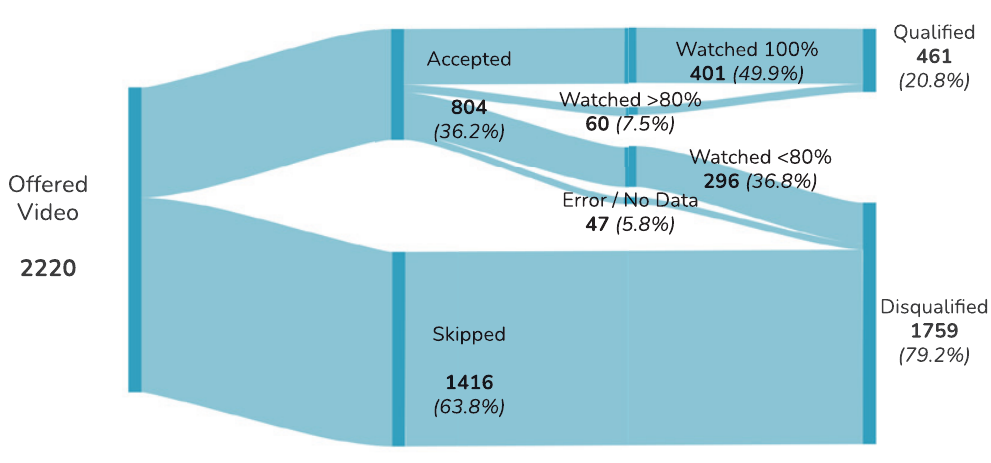
figure 7: The user interaction with the video – the numbers of video events for each group (source: